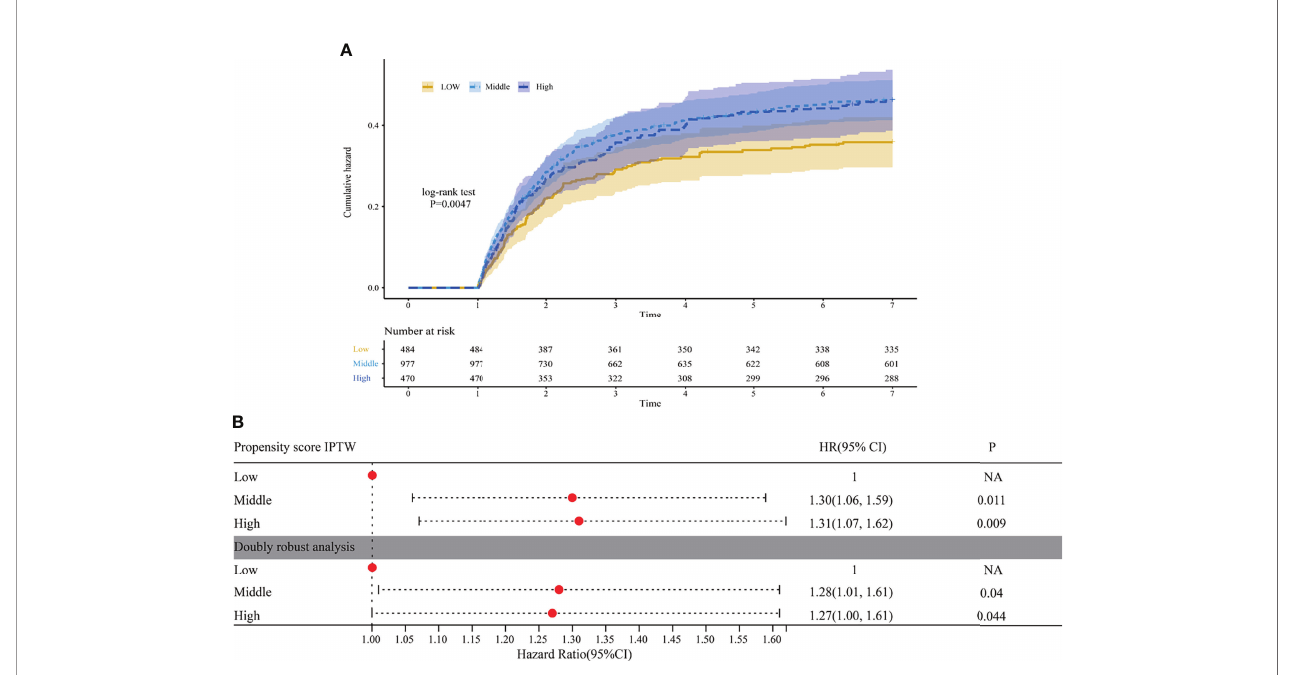
FIGURE 6 | (A) Cumulative incidence curve of sepsis acute kidney injury (S-AKI) in each N/LP groups were plotted by Kaplan-Meier method after inverse probability treatment weighting (IPTW); (B) the results of univariate Cox proportional hazard model after IPTW and double robust estimation regressed all 16 covariates. AKI was diagnosed based on serum creatinine and urine output criteria.